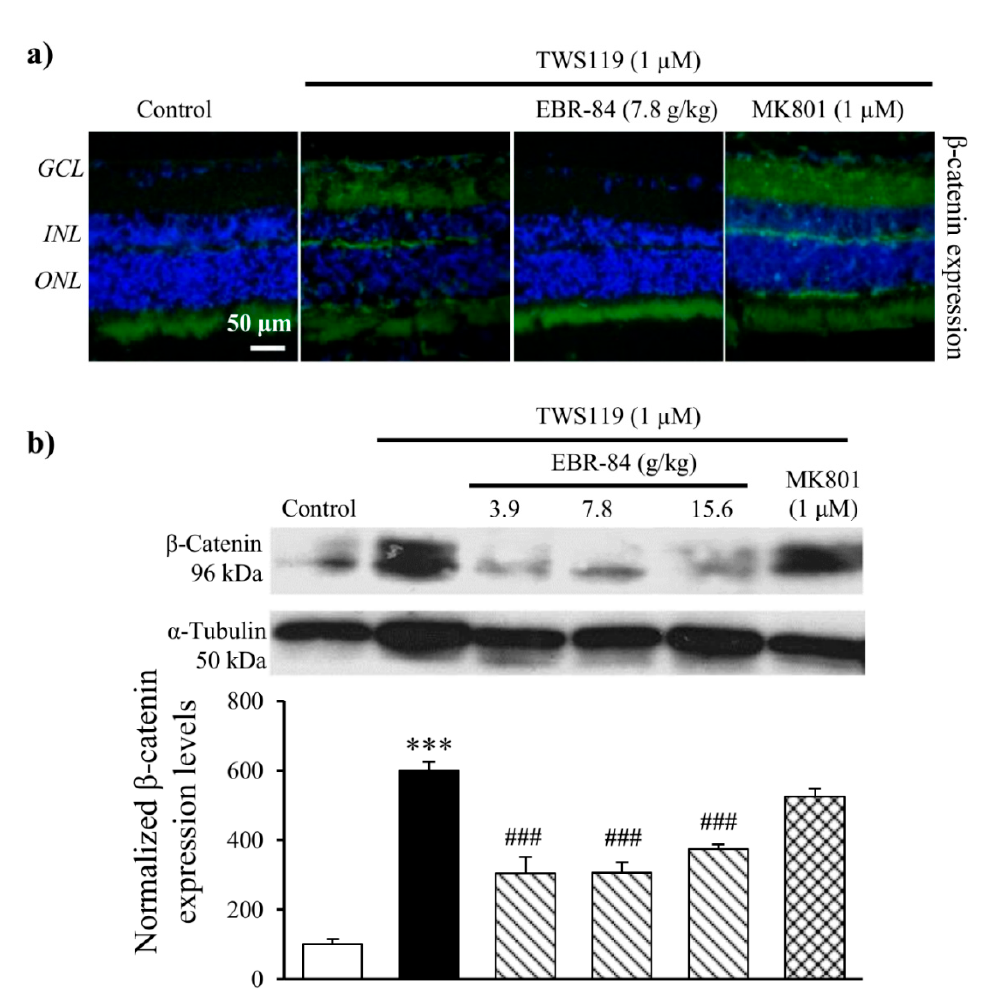
Figure 5. The effects of EBR-84 on β -catenin expression level in the retinas of TWS119-treated rats. ( a ) Representative images of immunofluorescence staining of β -catenin in the rat retinas. ( b ) The determination of nuclear β -catenin protein level from the rat retina tested using Western blot analysis ( n = 5). *** p < 0.001 vs. the control group; ### p < 0.001 vs. the TWS119 group. The magnification of all figures is × 200. Scale bar is 50 µ m for all images.